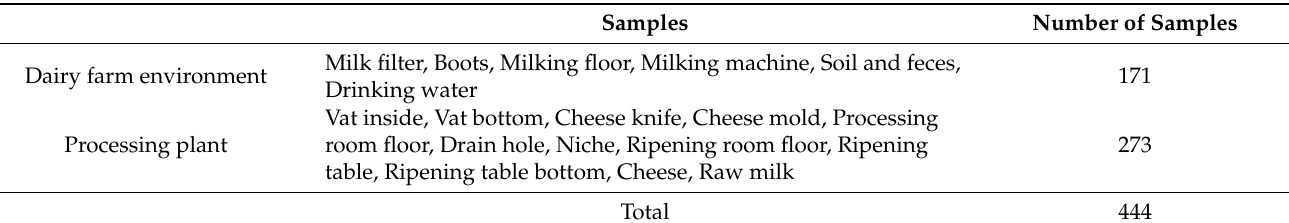
Table 1. Dairy farm environment and processing plant sample